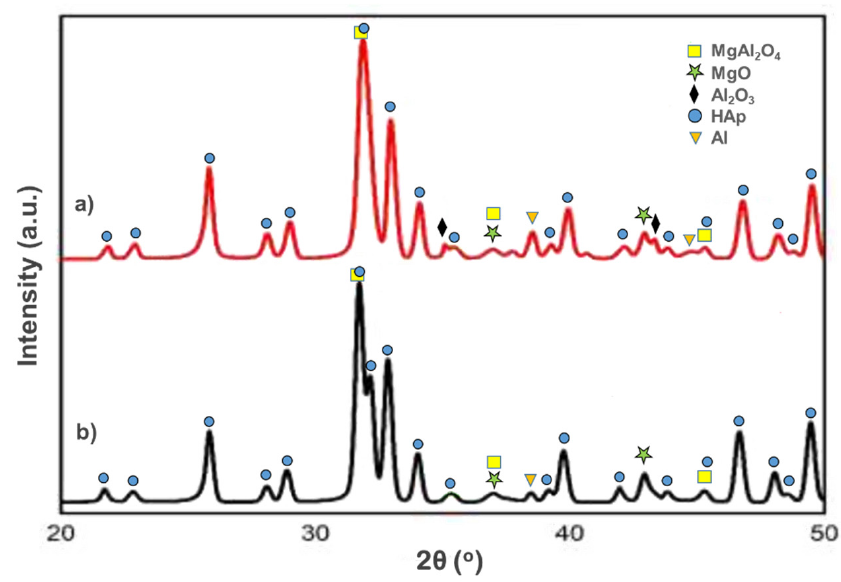
Figure 4. XRD of the hydroxyapatite composite made by compaction pressure of 100 MPa and Al particle size of ( a ) <90 and ( b ) >150 µ m.